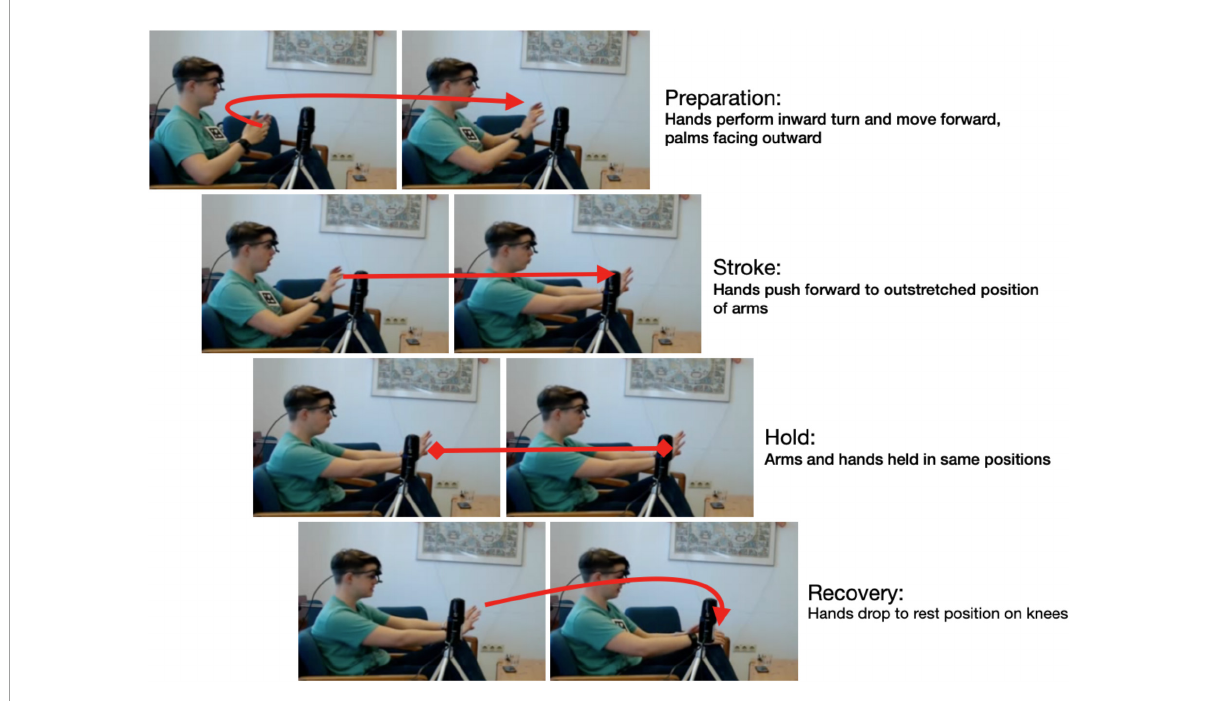
FIGURE1 Gesture phases illustrated: a gesture unit featuring all four gesture